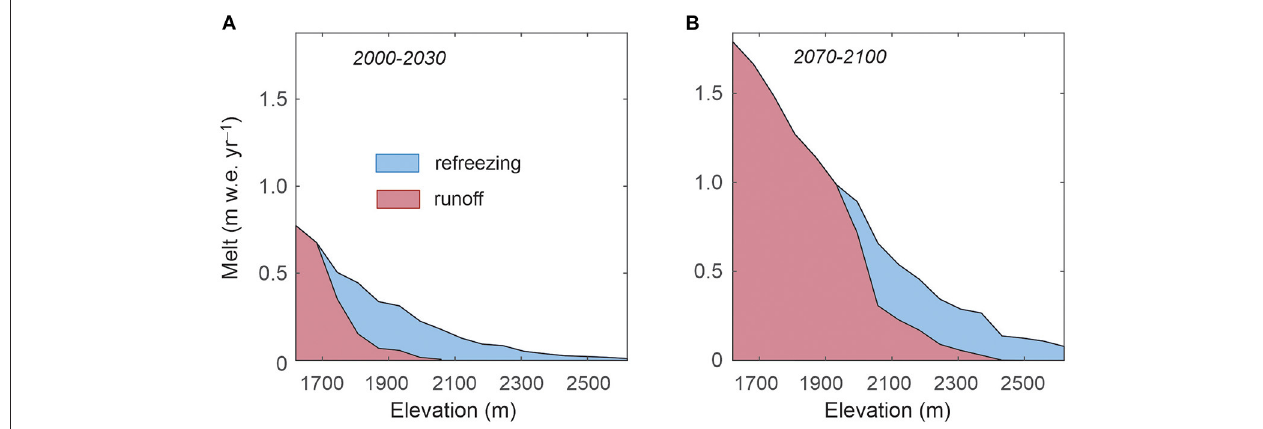
FIGURE 3 | Mean annual surface melt rates as a function of elevation for a transect at 66.5 ◦ N in southwest Greenland for (A) 2000–2030 and (B) 2070–2100. The red shading indicates the surface runoff and the blue shading indicates the meltwater retained by refreezing.